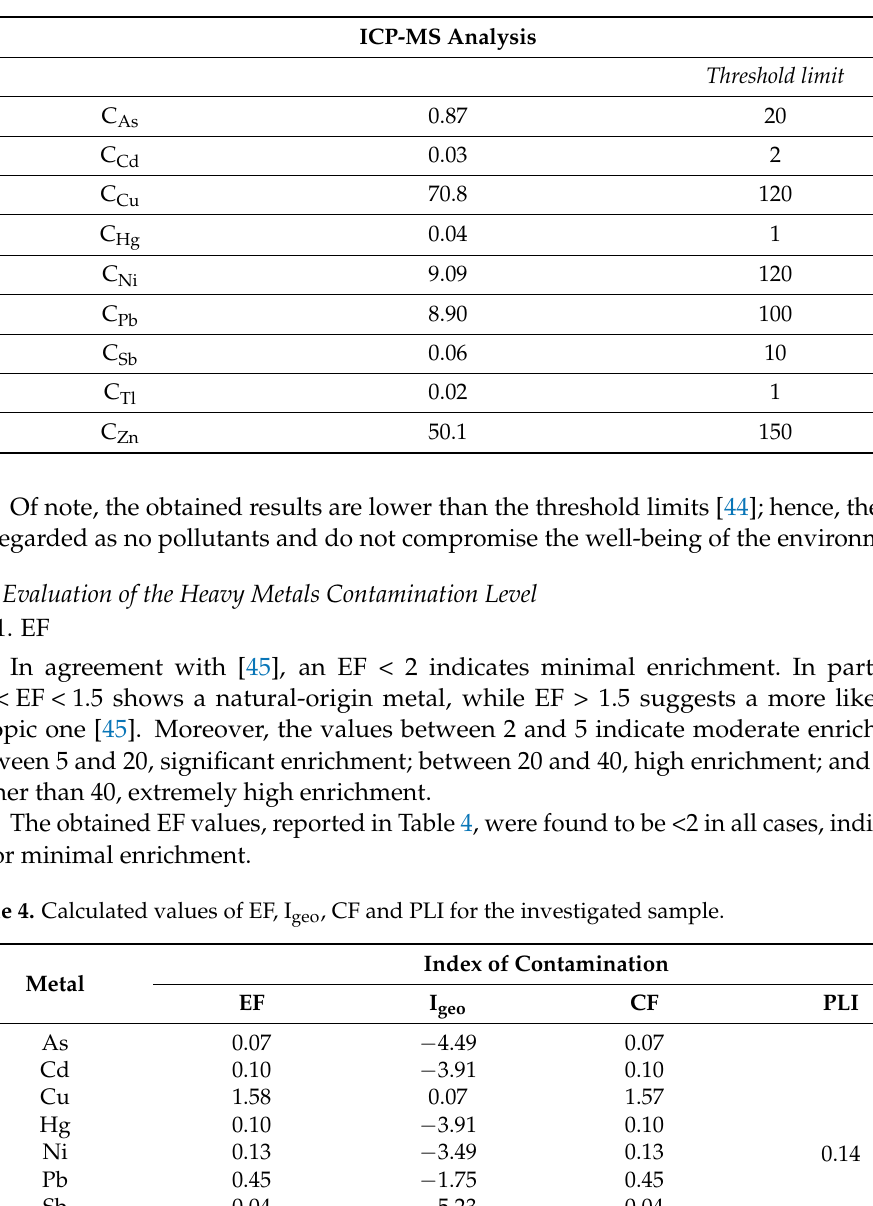
Table 3. Heavy metals content (mg kg − 1 d.w.) for the analyzed basalt aggregate for concrete.